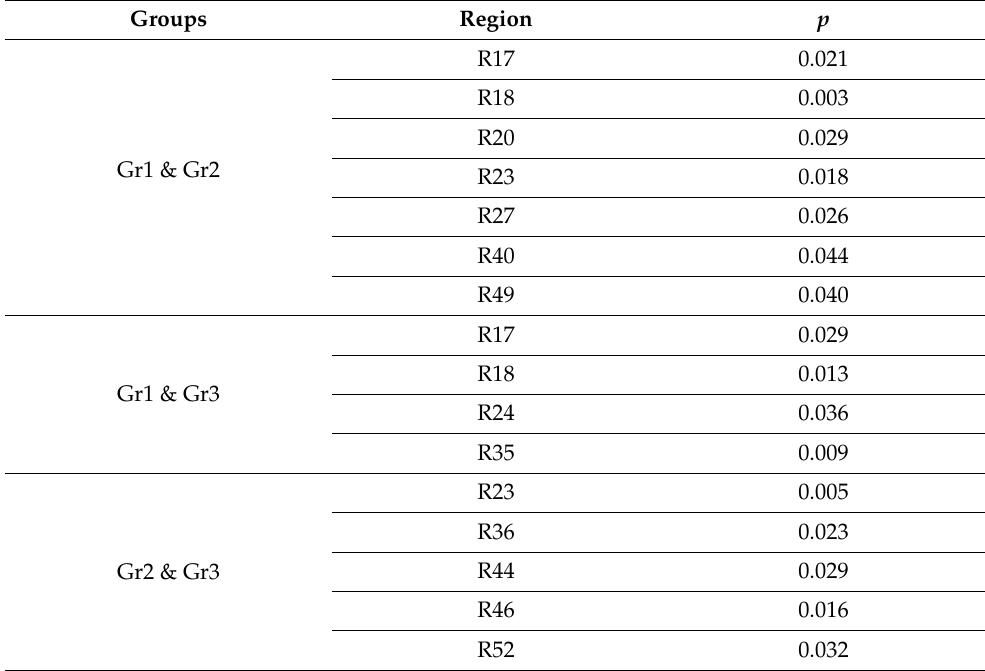
Table A4. Spectral regions with significantly different peak intensities between groups (matched- pair